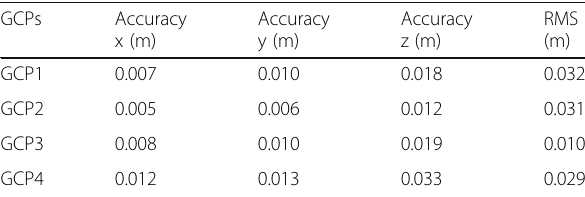
Table 2 Accuracies and RMS of the GCPs used for the georeferencing of